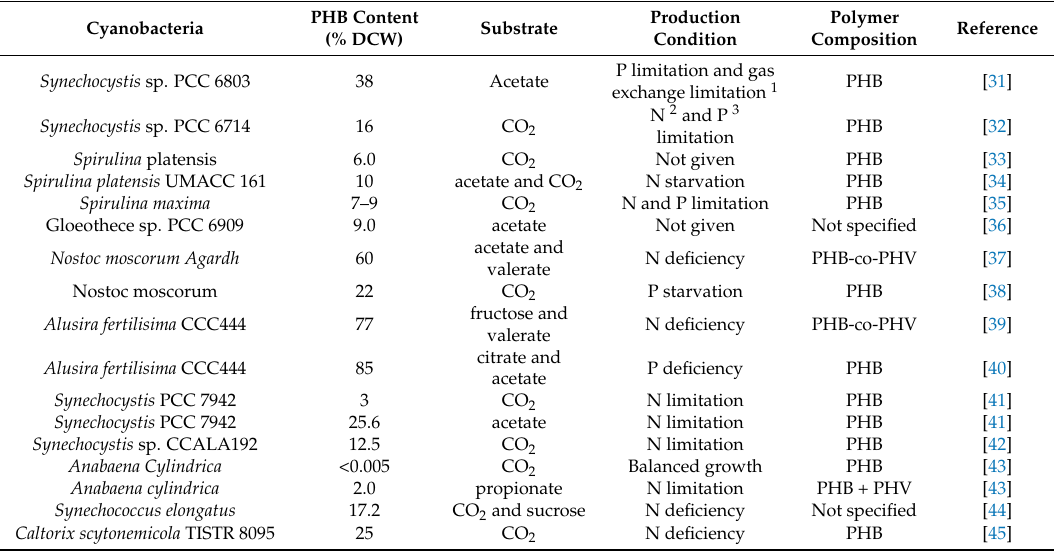
Table 1. Examples of wild-type cyanobacterial strains, with reported poly (3-hydroxybutyrate) (PHB) content, the carbon source, and growth conditions used for the production of the